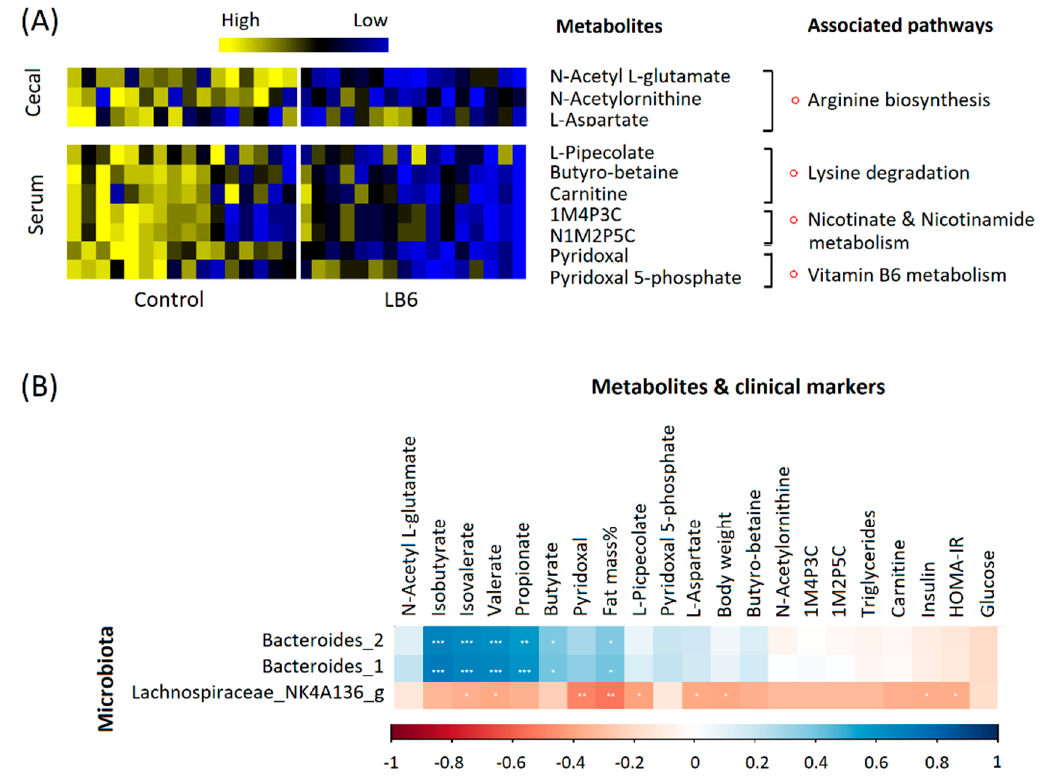
Figure 6. Putatively identified metabolites of significantly altered pathways in LB6 rats compared to control rats ( A ), and Pearson correlation of gut microbiota significant in both sexes with selected metabolites and clinical markers ( B ). 1M4P3C, 1-Methyl-4-pyridone-3-carboximide; N1M2P5C, N1- Methyl-2-pyridone-5-carboxamide. n = 7–8/group of each